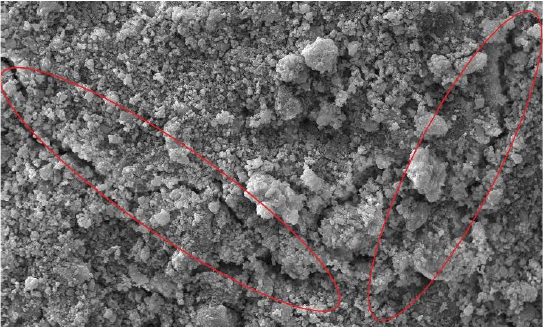
Figure 21. SEM image of OSA compact 2000× magnified exhibiting microcracks (cured at 75 °C, 10 bar, 100% CO 2 , 150 kgf/cm 2 ).